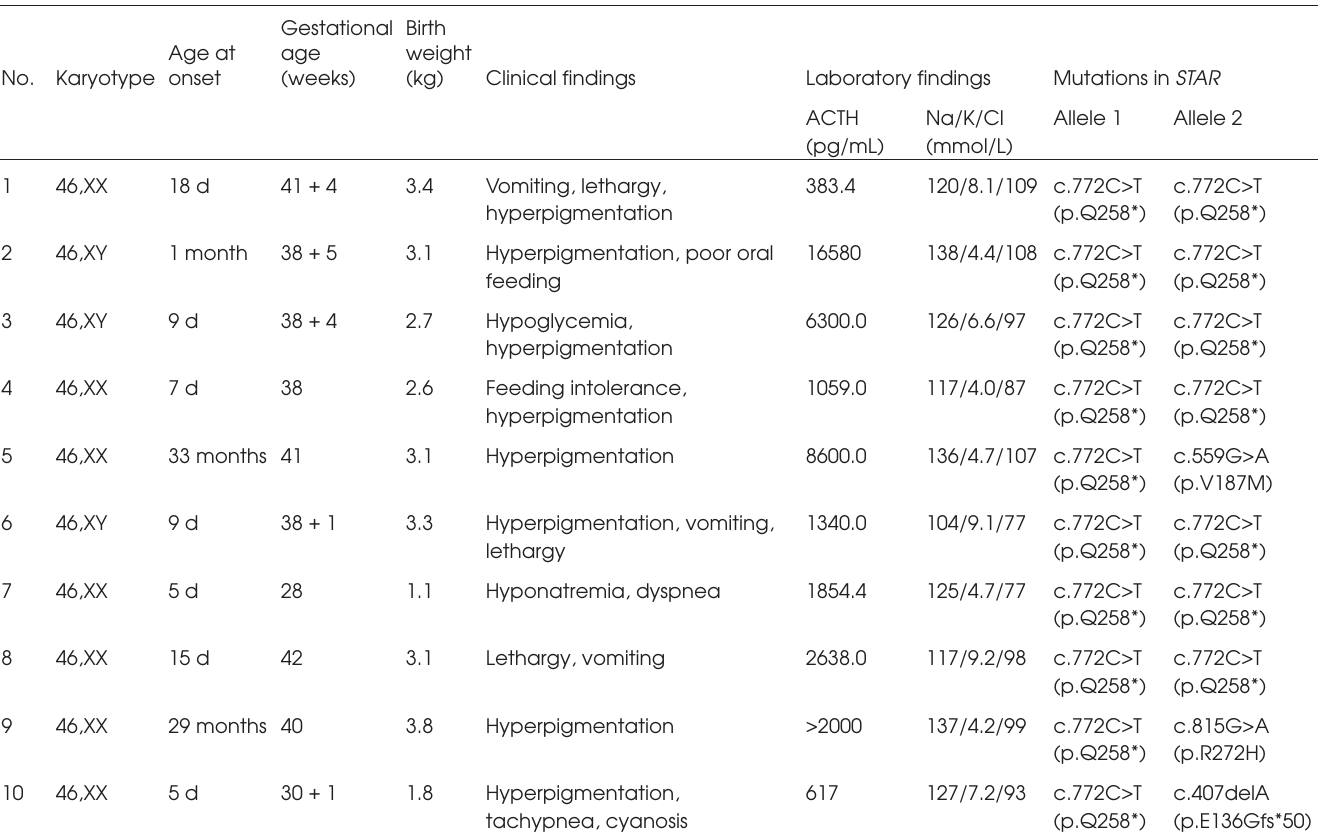
Table 1. Clinical and molecular characteristics of 10 patients with congenital lipoid adrenal hyperplasia who were subjected to haplotype